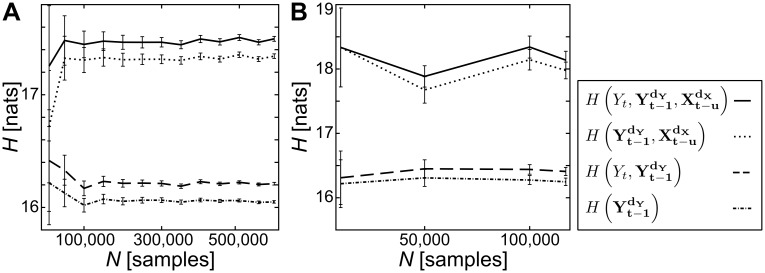
Examples for estimates of entropy (H) terms for transfer entropy calculation (Eq 12) by number of data points N, using the Nemenman-Shafee-Bialek-estimator (NSB).(A) entropies for ferret 1, V1, iso 0.5%: estimates are stable for N ≥ 100,000; (B) entropies for ferret 2, PFC, iso 0.0%: an insufficient number of data points does not allow for verification of the estimate’s robustness (recording was excluded from further analysis). Variables labeled X reflect data from the source variable, Y from the target variable. t is an integer time index, and bold typeface indicates the state of a system (see Methods).